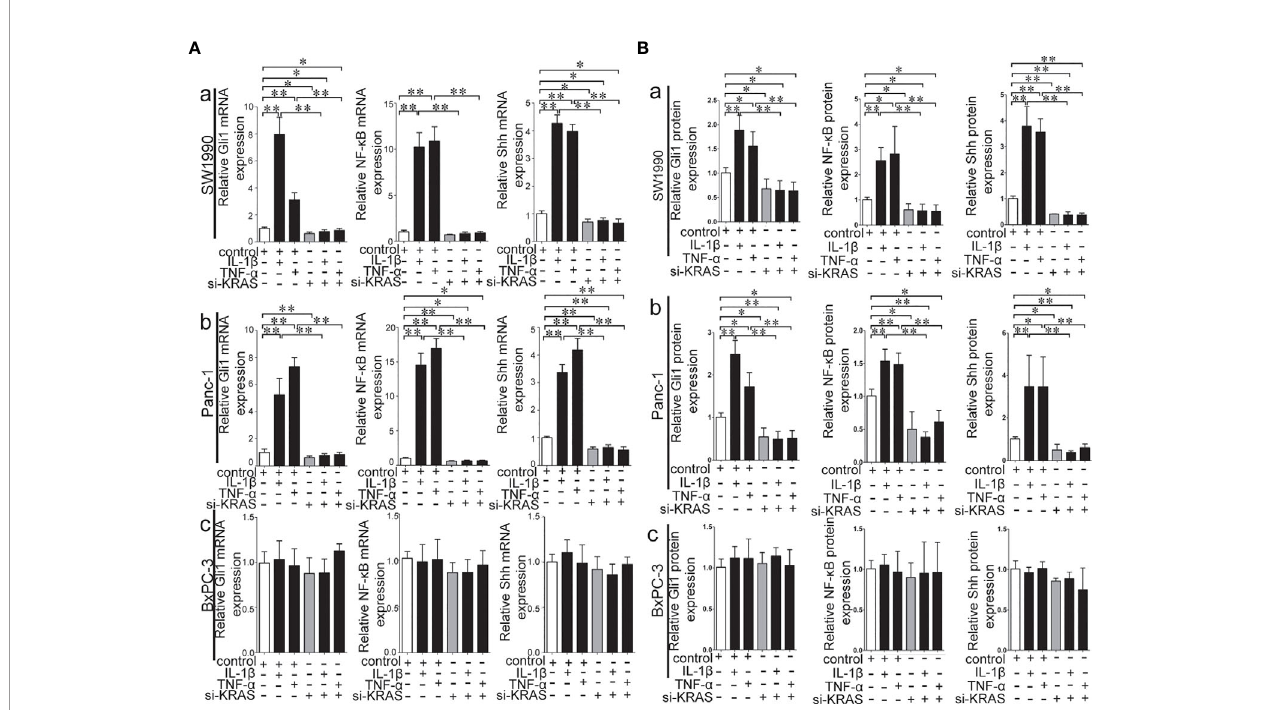
FIGURE 2 | Stimulatory effects on mRNA and protein expression of Gli1, NF- k B and Shh on PDAC cell lines treated with IL-1 b and TNF- a alone or in combination with si-KRAS. (A) represented mRNA expression in three PDAC cell lines; (B) represented gray analysis of relative protein expression; [a. SW1990, b Panc-1, c BxPC-3]. All data were obtained from three independent experiments. *p < 0.05; **p < 0.01.